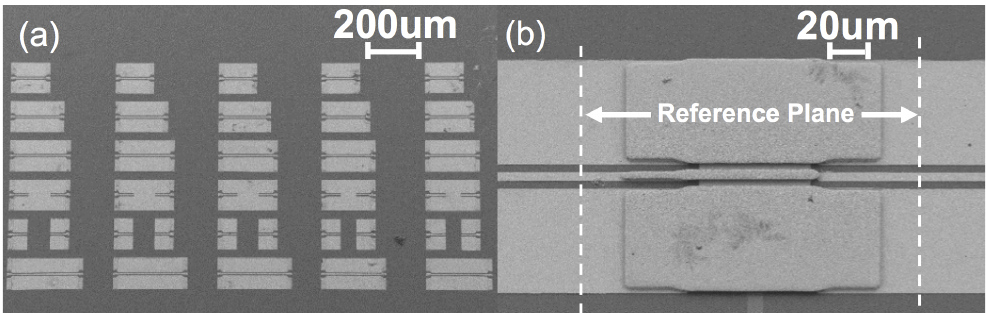
Figure 17. SEM image of ( a ) on-wafer TRL calibration kit and ( b ) an example silicon